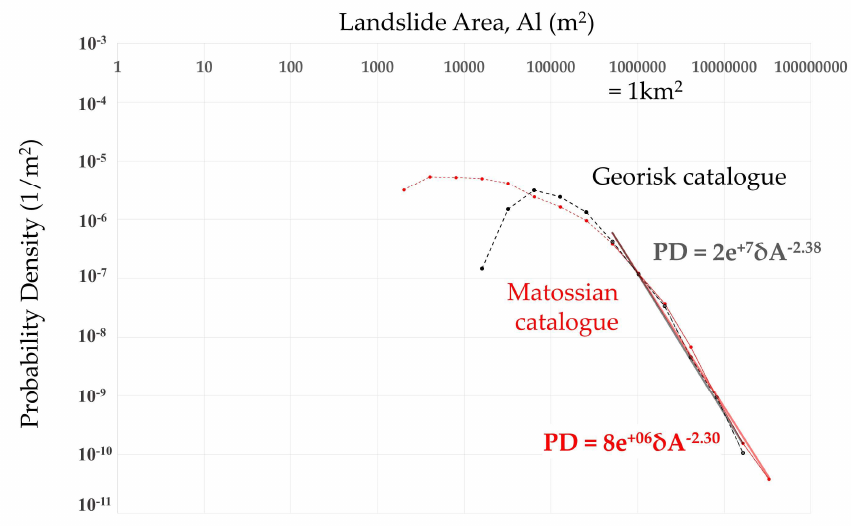
Figure 8. Size-frequency statistics for the Matossian (red) and Georisk (black) catalogues. Power law fits to the tails of the probability density distributions (solid straight lines) have exponents of –2.3 and –2.38 for the Matossian and Georisk catalogues, respectively.